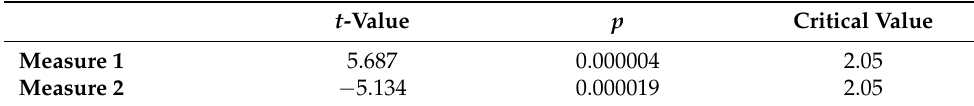
Table 12. Obtained t -test